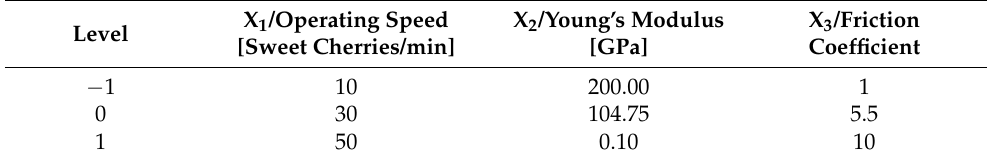
Table 2. Test factors’ level and coding.